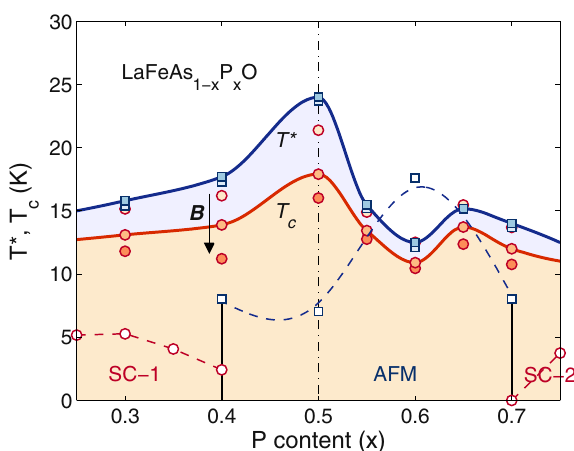
Fig. 7 Phase diagram of LaFeAs 1 − x P x O showing the critical temperature T c and that of the spin- fl uctuation maxima T * at different applied fi elds (vertical arrow: 0, 3.5, and 7 T), measured via magnetometry and NMR, respectively. While the onset of super- conductivity is suppressed by the applied fi eld, the T * values remain unaffected. Empty symbols and dashed lines refer to the phase diagram of the material grown at ambient pressure, 24 exhibiting two SC phases separated by an antiferromagentic phase. For clarity, the latter temperature values were reduced by